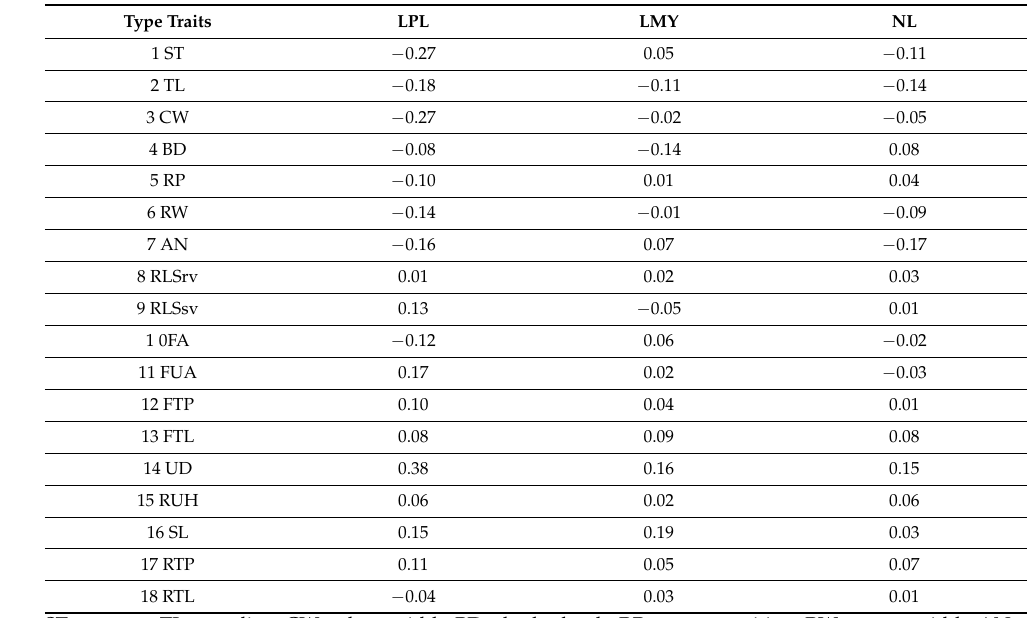
Table 7. Genetic correlations (r xy ) between the longevity traits and type